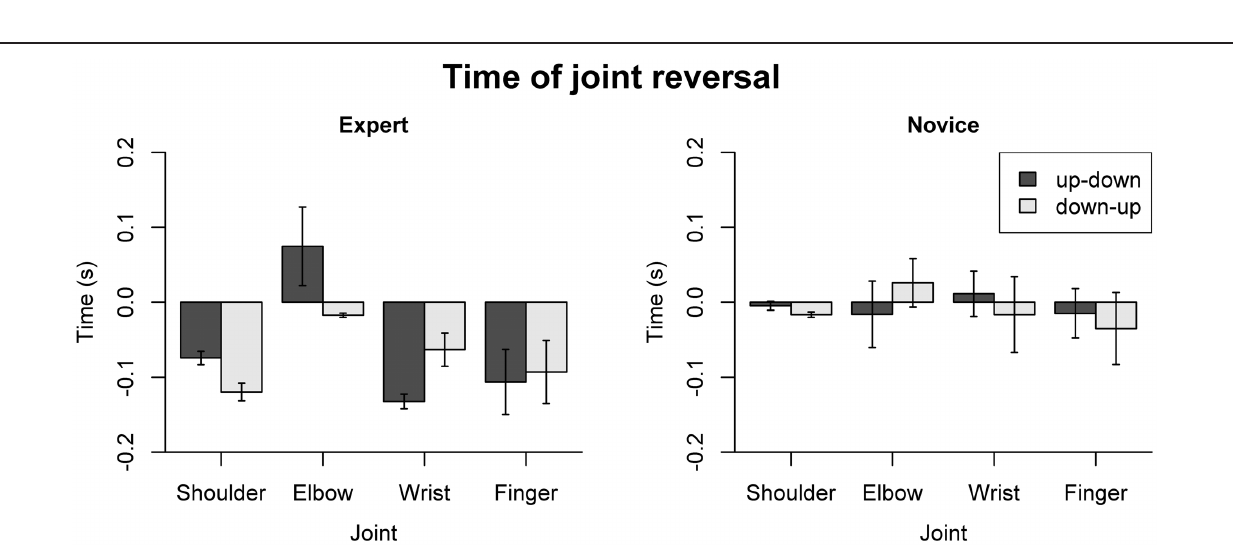
FIGURE 8 | Dependent variables describing the timing of joint reversals. Error bars indicate SE across